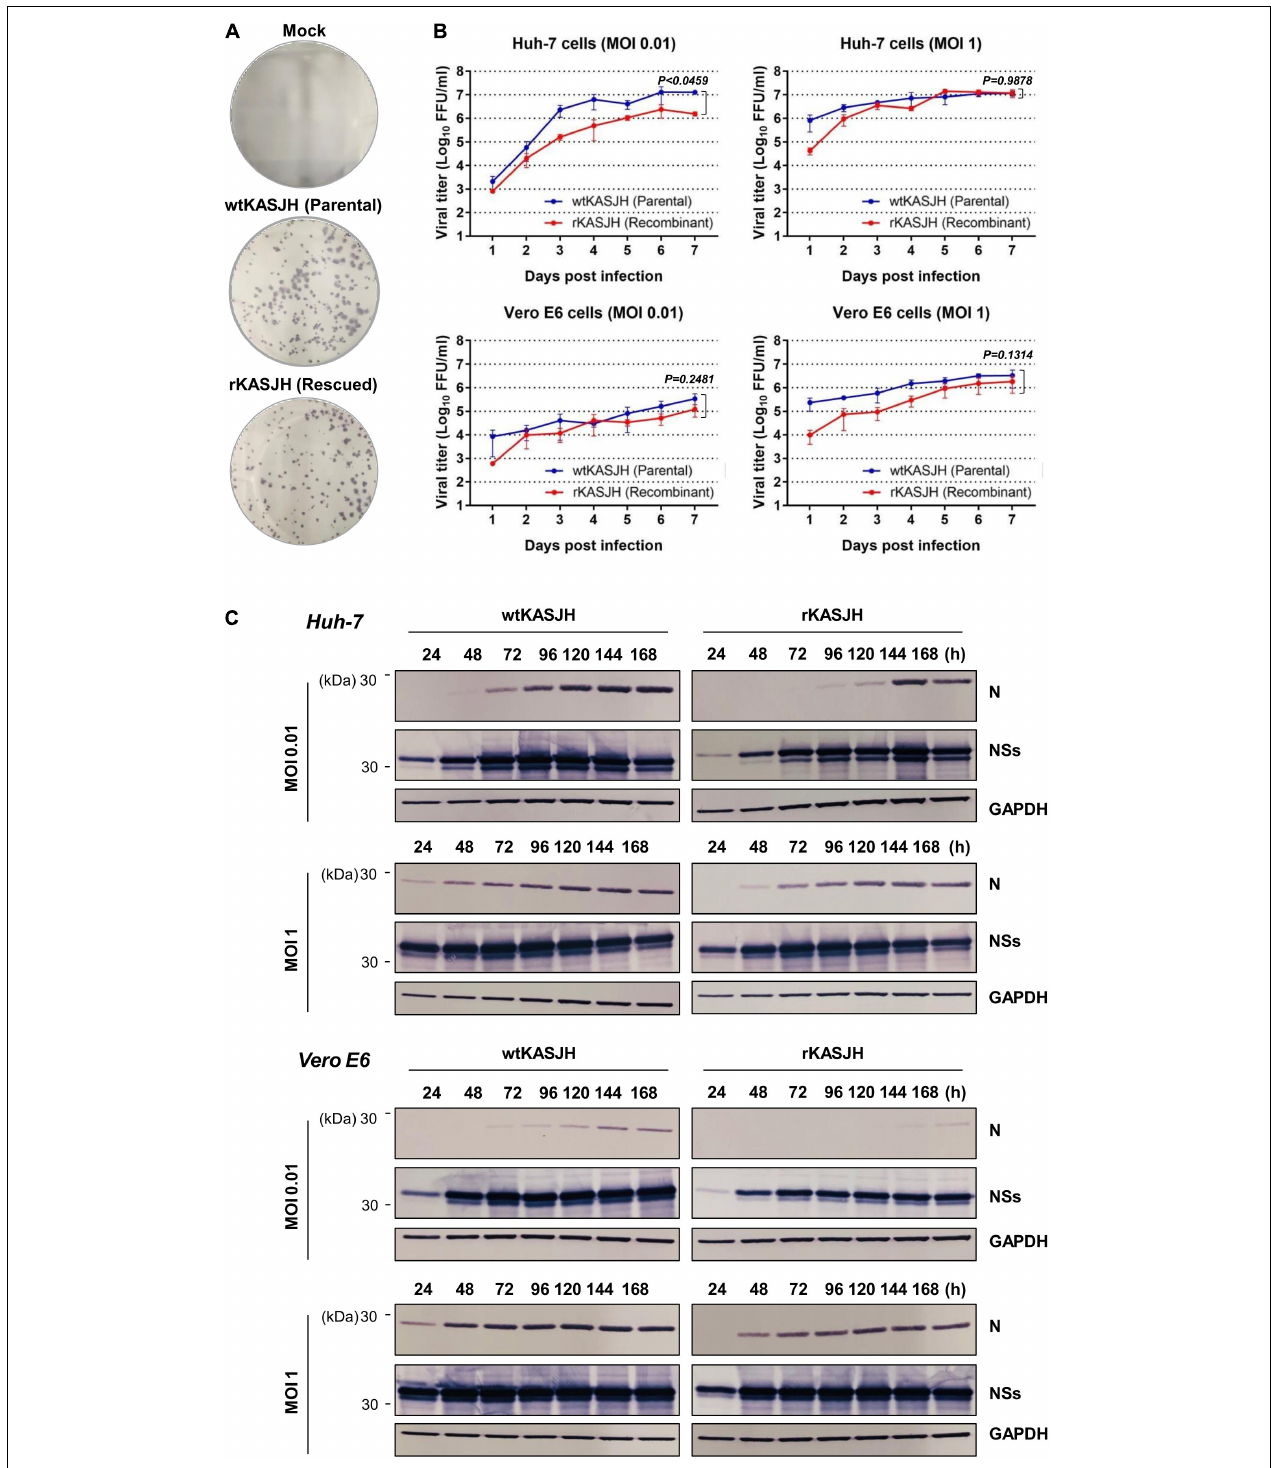
FIGURE 2 | Characterization of parental and rescued SFTSVs in cell culture. (A) Representative focus morphology in Vero E6 cells immunostained with anti-SFTSV N antibody 7 dpi. (B) Growth kinetics of Vero E6 and Huh-7 cells infected with wtKASJH or rKASJH at MOIs of 0.01 and 1 FFU/cell and infections were performed in triplicate. Culture supernatants were collected from the infected cells at the indicated days after infection and virus titers were determined by focus-forming assays. Error bars indicate standard deviations of the mean. Statistical significance between wtKASJH and rKASJH infected groups was determined by an unpaired, two-tailed t -test. (C) Viral protein synthesis from parental and recombinant viruses in Vero E6 and Huh-7 cell lysates detected by immunoblotting with anti-SFTSV N, anti-SFTSV NSs, and anti-GAPDH antibodies.